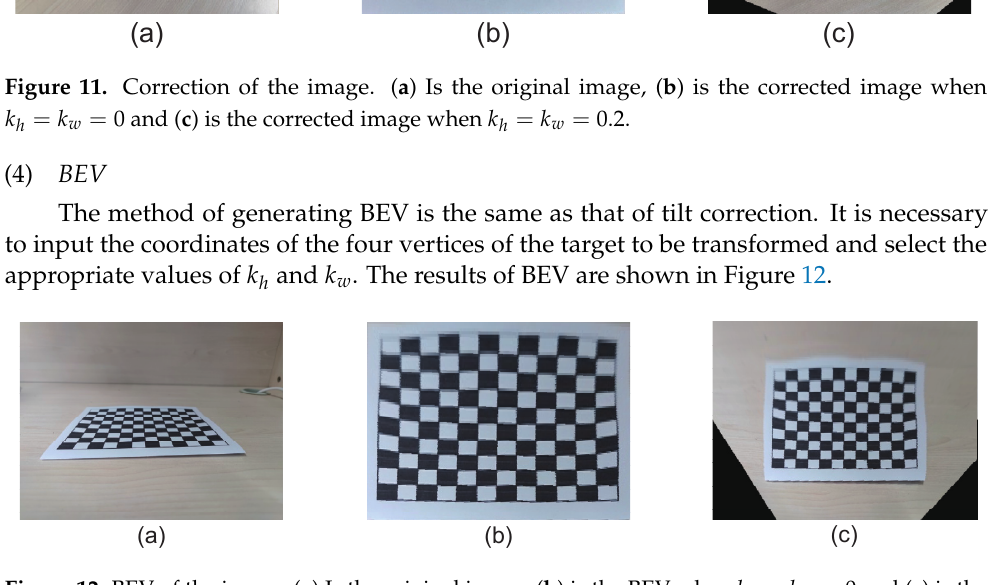
Figure 12. BEV of the image. ( a ) Is the original image, ( b ) is the BEV when k h = k w = 0 and ( c ) is the BEV when k h = k w = 0.2.